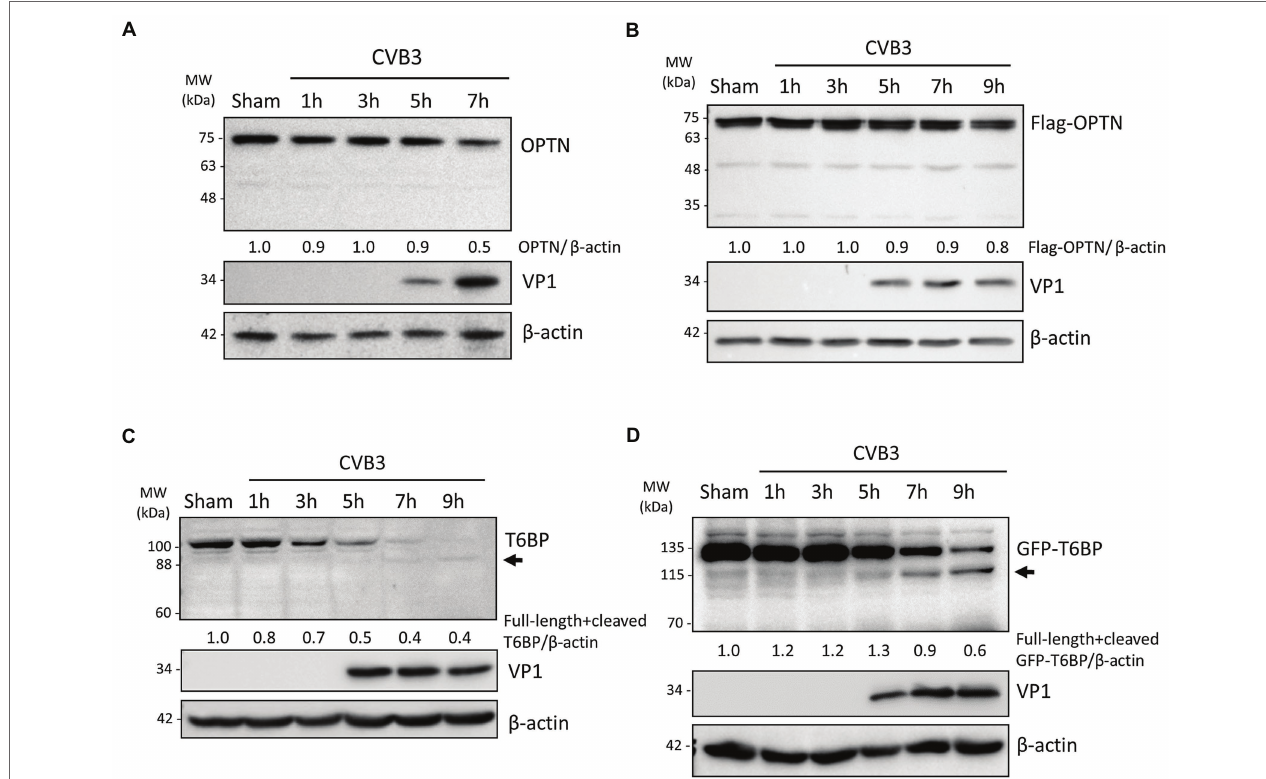
FIGURE 2 | CVB3 targets selective autophagy receptor T6BP but not OPTN. ( A and C ) HeLa cells were sham- or CVB3-infected (MOI = 10) for 1 h, 3 h, 5 h, 7 h, or 9 h as indicated. Cell lysates were harvested and probed with anti-OPTN (A) or anti-T6BP (C) . Protein levels of OPTN and both full-length and cleaved T6BP were quantified by densitometric analysis using NIH ImageJ, normalized to β -actin, and presented underneath the blot. Viral capsid protein (VP1) was used as a marker of CVB3 replication. Arrow denotes potential cleavage fragment. ( B and D ) HeLa cells were transfected with Flag-OPTN (B) or GFP-T6BP (D) for 24 h prior to CVB3 infection as above. Cell lysates were probed with either anti-Flag or anti-GFP antibody. Protein levels of T6BP were quantified as